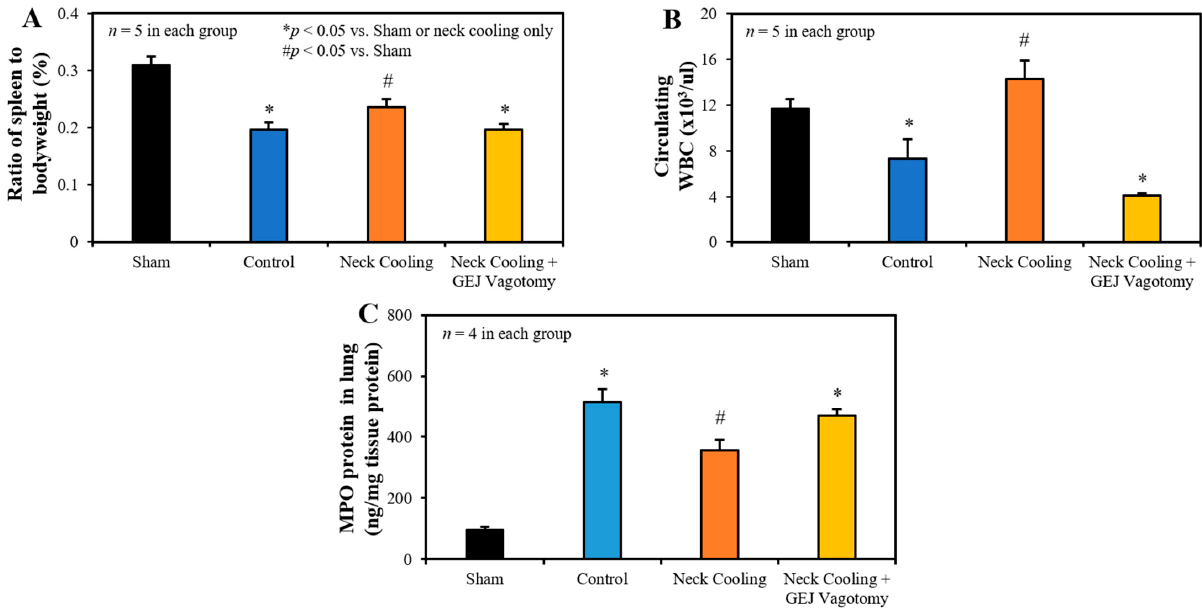
Figure 4. ( A ) Spleen to bodyweight ratio, ( B ) circulating white blood cells, and ( C ) myeloperoxidase (MPO) in the lung 3 hours after CLI in each group. GEJ: Gastroesophageal junction.